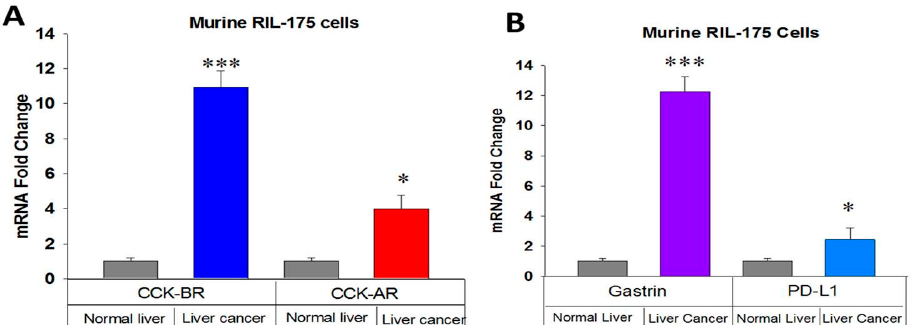
Figure 1. Characterization of murine RIL-175 HCC cells in vitro. ( A ) Cholecystokinin-B receptor (CCK-A) and cholecystokinin-A receptor (CCK-B receptor) mRNA expression is significantly in- creased in RIL-175 HCC cells by qRT-PCR compared to normal mouse liver. ( B ) Gastrin and PD-L1 expression by qRT-PCR are increased in RIL-175 mouse HCC cells compared to normal mouse liver. *** p < 0.001; * p < 0.05.